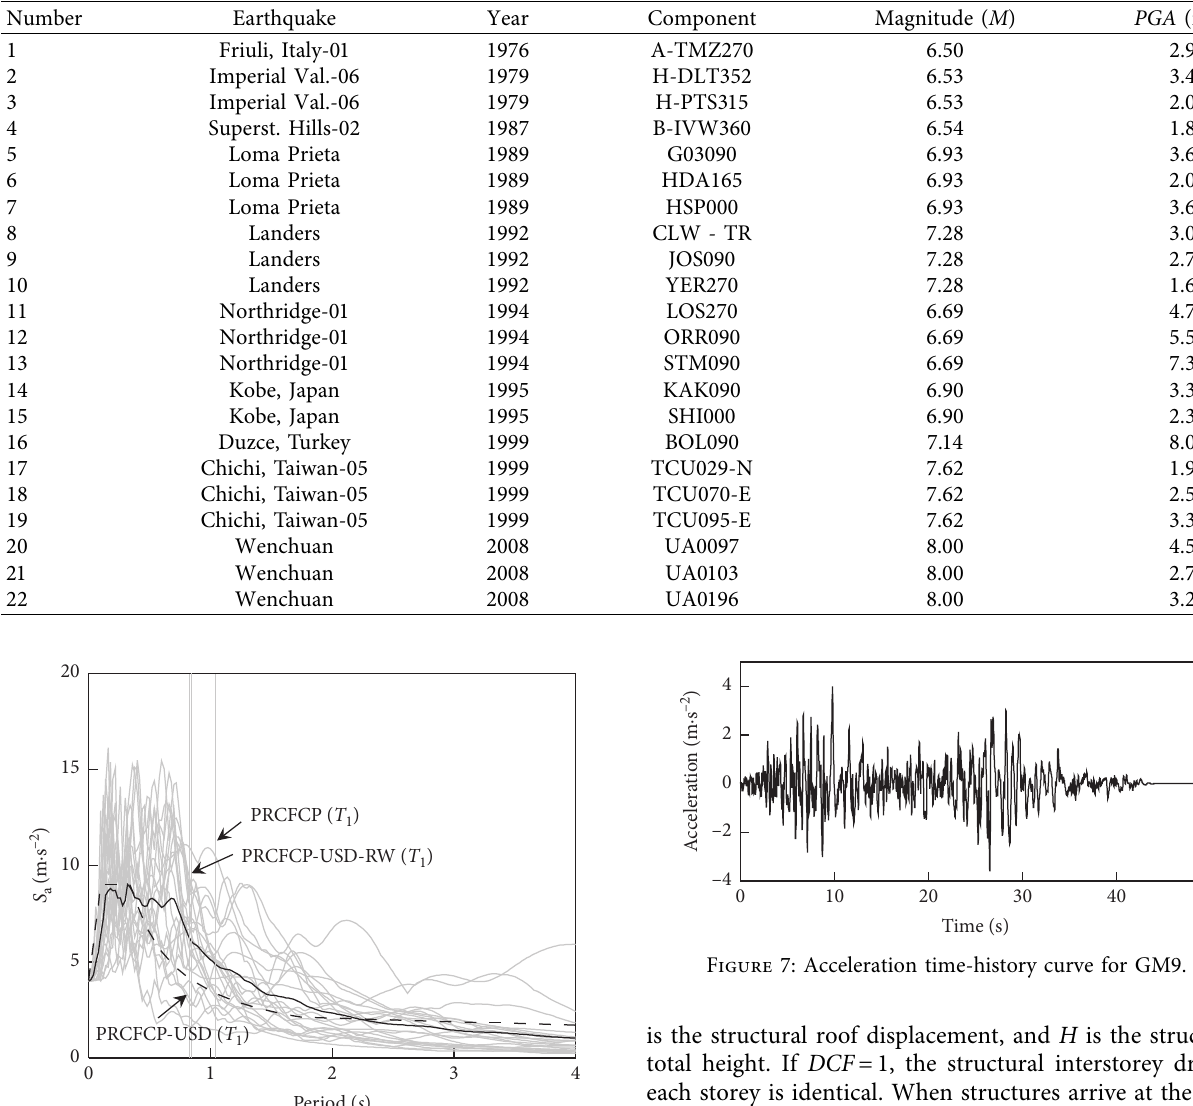
Table 2: 22 ground motions recommended in [26].